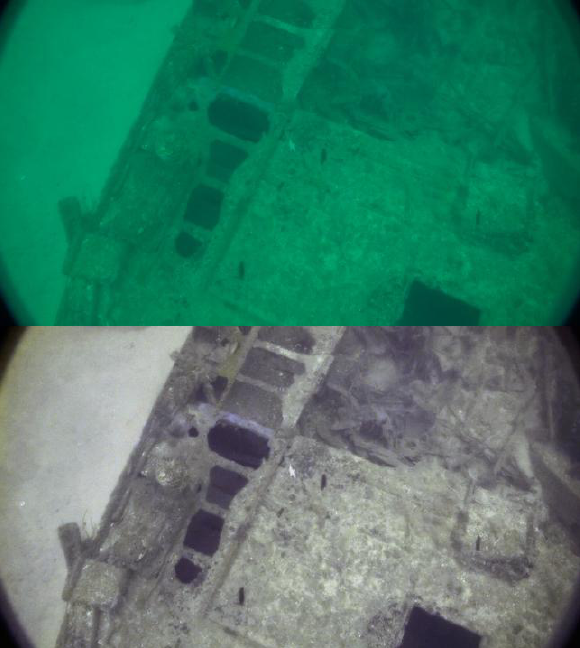
Figure 7: An example of video-frame before (up) and after (down) of LAB + ACE filters applied